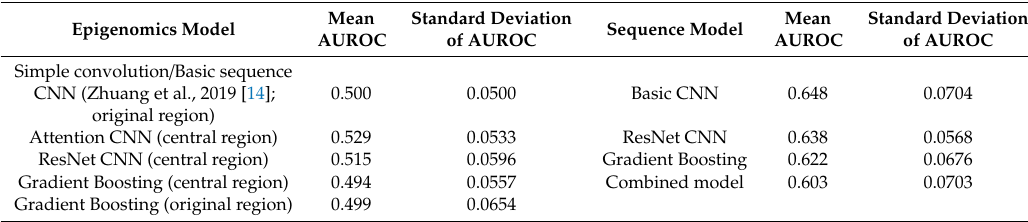
Figure 7. Validation AUROCs for epigenomics ResNet CNNs with various configurations in Table 3: ( a ) the number of ResNet blocks and number of filters for each convolution; ( b ) the filter / kernel size in the first layer and number of fully-connected neurons in the last layer. Table 4. Epigenomics and sequence model performance.